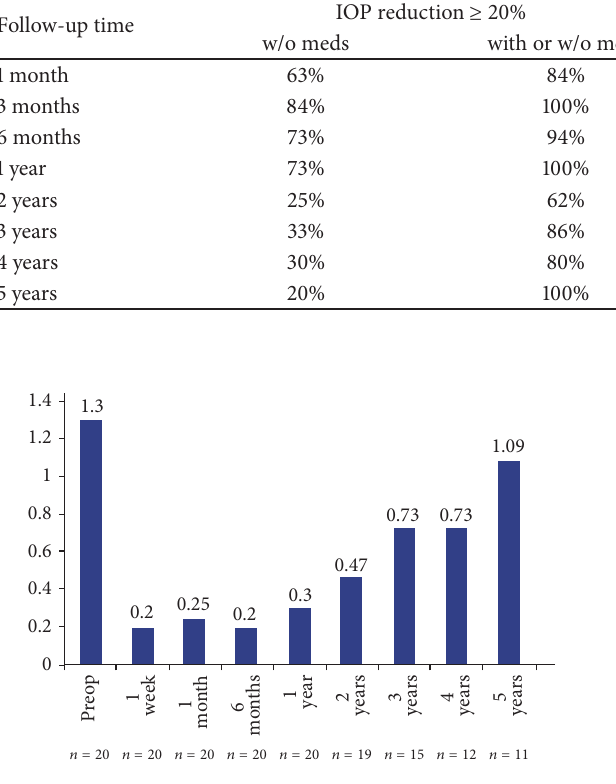
Figure 3: Use of glaucoma medications at each follow-up visit.